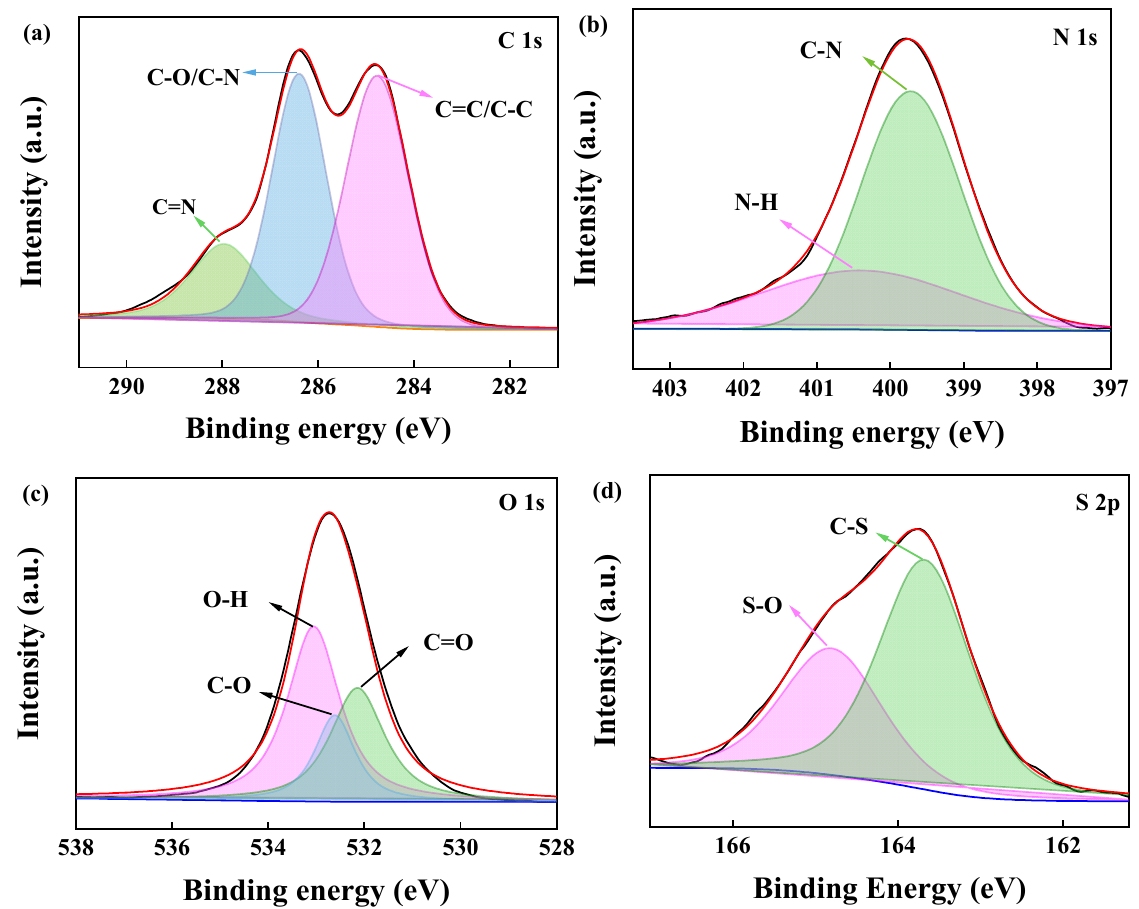
Figure 3. XPS-peak-differentiation-imitating analyses of BJ160: ( a ) C1s (green: C=N; blue: C-O/C-N; pink: C=C/C-C), ( b ) N1s (green: C_N; pink: N-H), ( c ) O1s (green: C=O; blue: C-O; pink: O-H) and ( d ) S2p (green: C-S; pink: S-O).